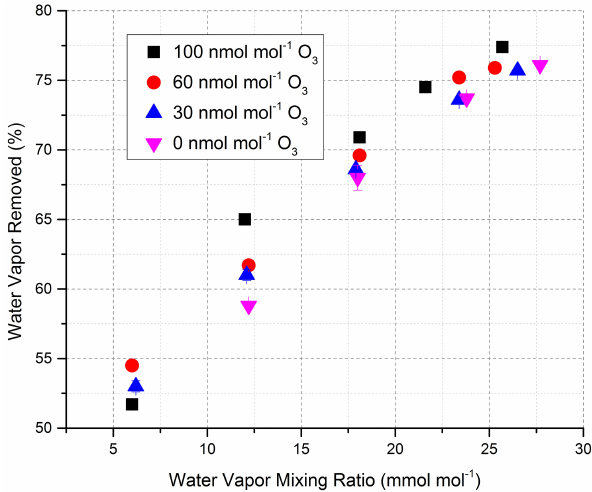
Fig. 5. Fraction of water vapor removed by the Nafion dryer versus the absolute water vapor mole fraction upstream from the Nafion dryer. Data are color-coded according to ozone